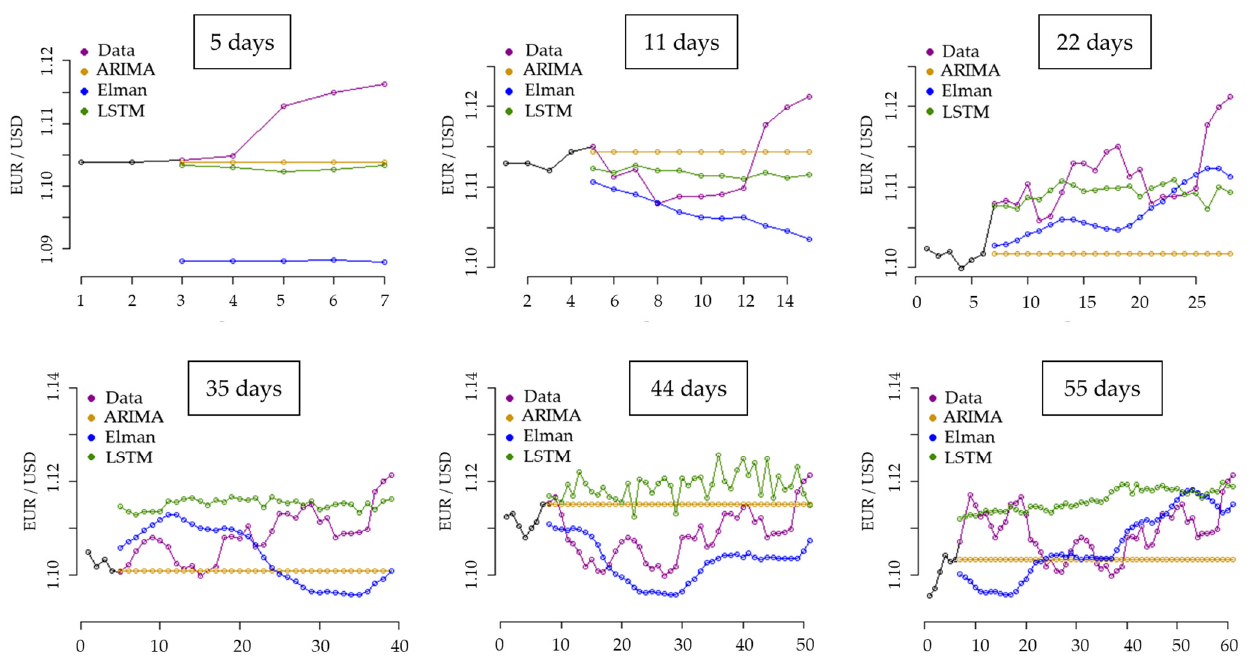
Figure 7. Forecasting method comparison using six different prediction horizons.